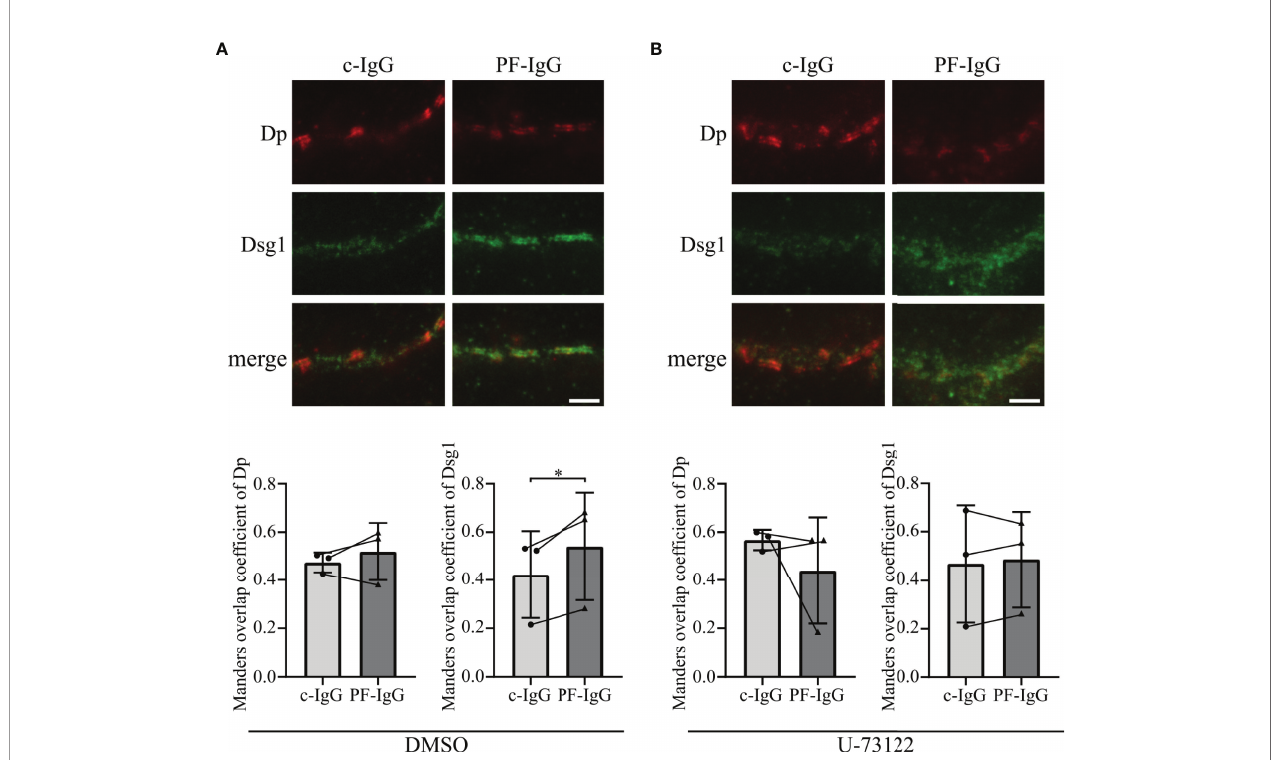
FIGURE 5 | PF-IgG induced redistribution of Dsg1 within the cell membrane can be prevented by PLC inhibition. (A) Top: Representative immunostainings of HaCaT cells stained for desmoglein 1 (Dsg1) and desmoplakin (Dp), incubated 24 h with IgG fractions and DMSO as control. Scale bar: 1 µm. Bottom: Manders overlap coef fi cient of Dp with Dsg1 (left) and Dsg1 with Dp (right). N=3; each dot represents the mean of >3 acquisitions from one independent experiment. *P<0.05; error bars represent standard deviation (SD). (B) Top: Representative immunostainings of HaCaT cells stained for Dsg1 and Dp, incubated 24 h with IgG fractions and U-73122. Scale bar: 1 µm. Bottom: Manders overlap coef fi cient of Dp with Dsg1 (left) and Dsg1 with Dp (right). N=3; each dot represents the mean of >3 acquisitions from one independent experiment. *P<0.05 in two-tailed paired Student ’ s t-test; error bars represent standard deviation.